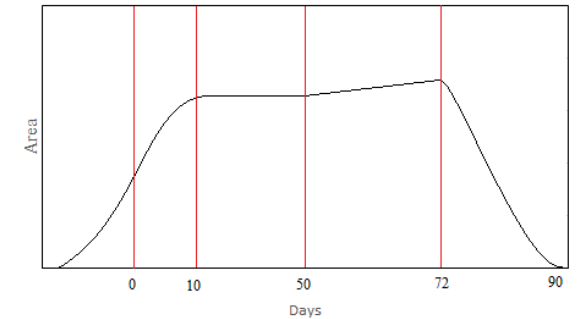
Figure 16. Generalized intraseasonal guano extent change. Peak of egg laying on day 0. Constant area after day 10. Peak of Hatching on day 50. First crèche on day 72. End of season on day